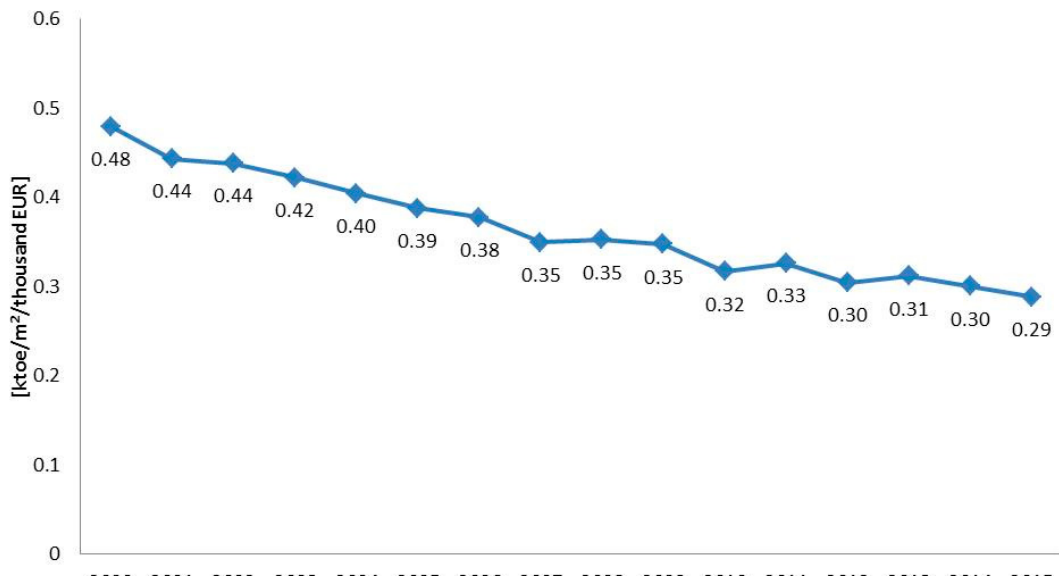
Figure 18. Evolution of the EU-28 specific residential Final Energy Consumption (FEC) corrected for climatic and economic conditions ( 𝑠𝐹𝐸𝐶 (cid:3030),(cid:3032) ) over the period of 2000–2015 Source: Eurostat, Odyssee.